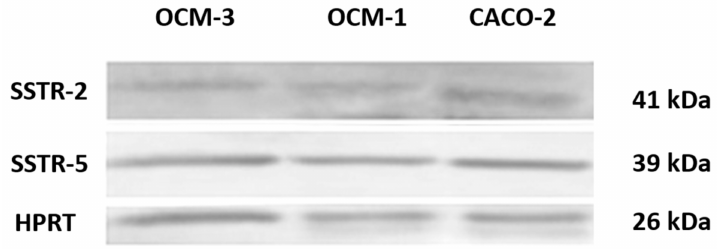
Figure 4. Western blot analysis of SSTR-2 and SSTR-5 protein in human cell